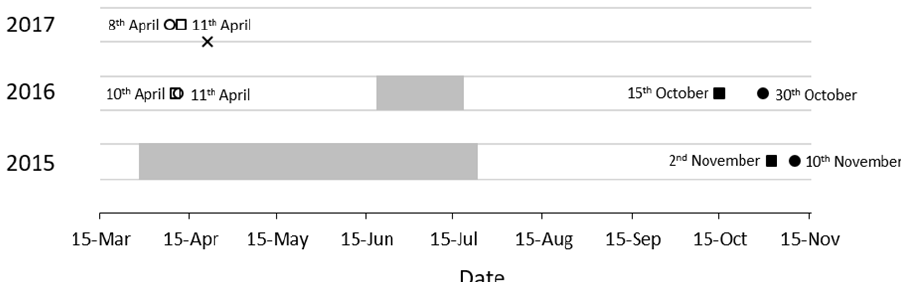
Figure 1. The beginning and end of growing seasons in the control and drought treatment (DT) plots in three consecutive years (2015, 2016 and 2017). Open symbols indicate the mean bud burst date in the control (square) and DT (circle) plots, whilst closed symbols indicate the mean date of autumn leaf senescence in the control (square) and drought treatment (circle). The symbol × indicates the late frost event (on 21st April 2017). Grey polygons indicate the duration of drought treatments in 2015 (from 30th March to 21st July) and 2016 (from 20th June to 16th July).